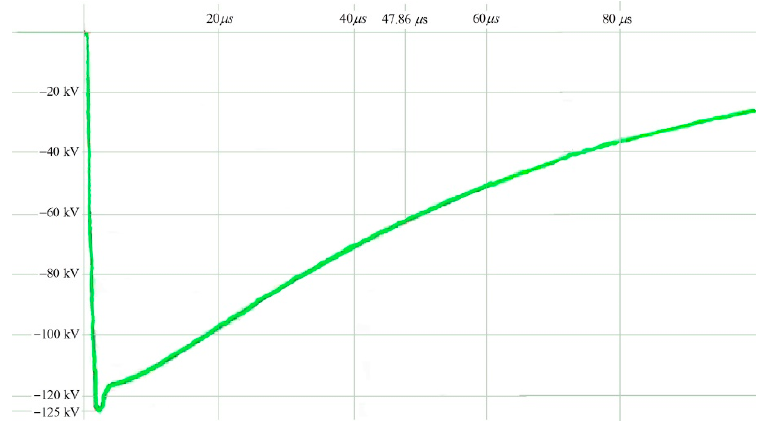
Figure 3. Quasi double peak impulse voltage, laboratory test, 125 kV.